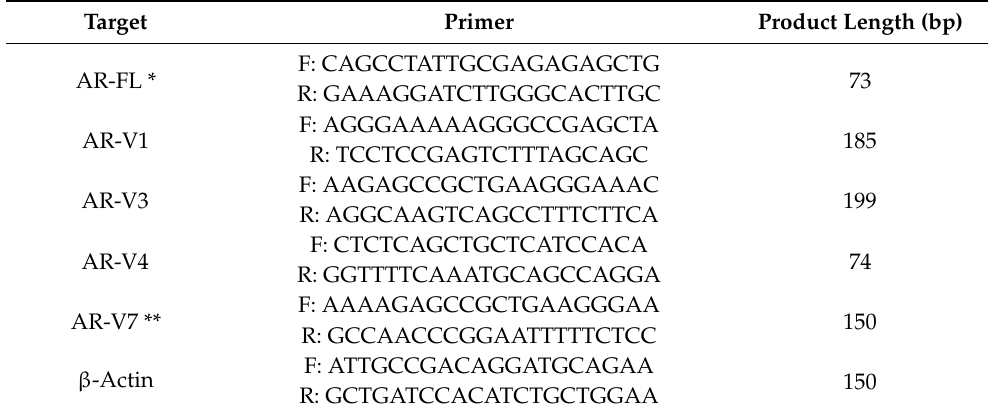
Table 1. Primers used in qPCR. (*—[28],